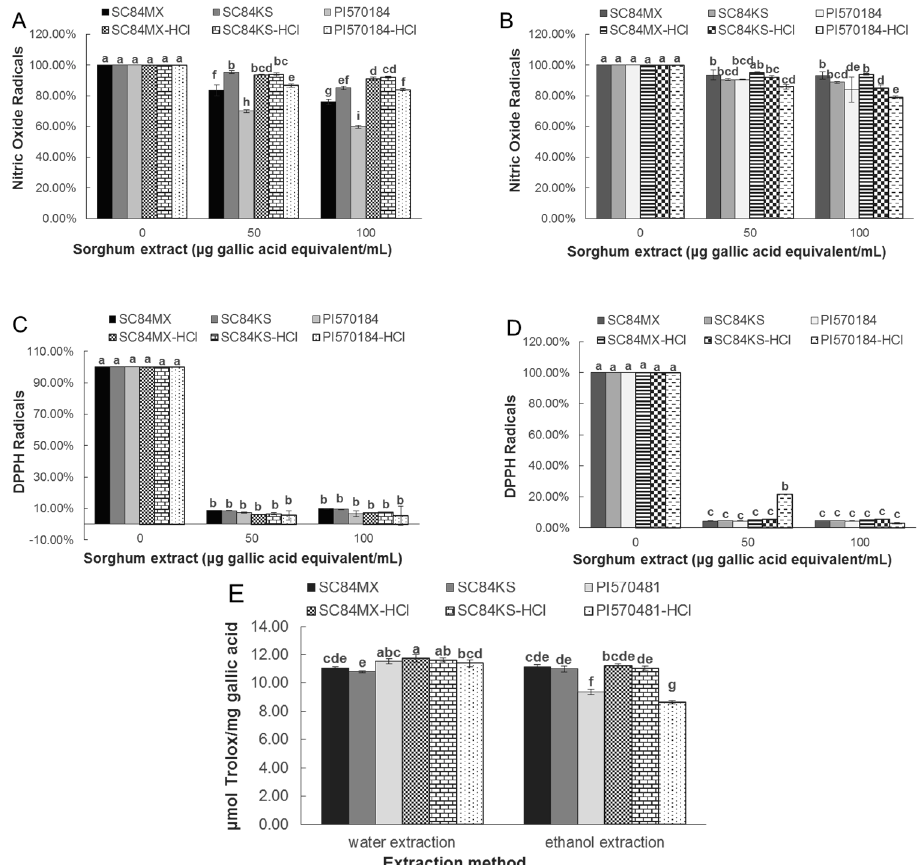
Figure 2. Antioxidant properties of sorghum phenolics extracts. Nitric oxide (NO) scavenging activity of ( A ) water extracts and ( B ) ethanol extracts; 2,2-diphenyl-1-picrylhydrazyl (DPPH) scavenging activity of ( C ) water extracts and ( D ) ethanol extracts; ( E ) oxygen radical absorbance capacity (ORAC) values of water and ethanol extracts. The percentage production of NO and DPPH were calculated with respect to the control. Error bars are standard deviations ( n ≥ 3). Di ff erent letters a–i above columns indicate significant di ff erences ( p <